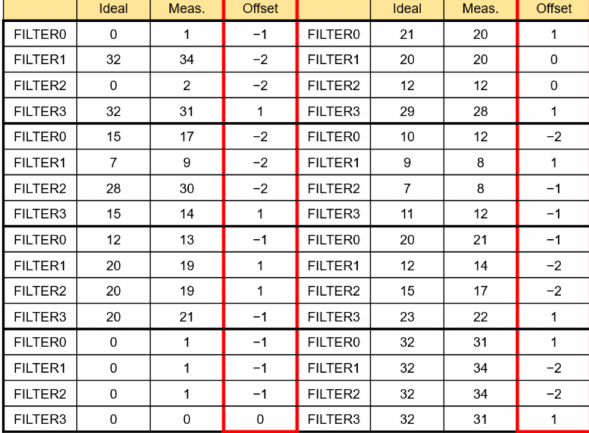
Figure 22. Measurement results of filters output